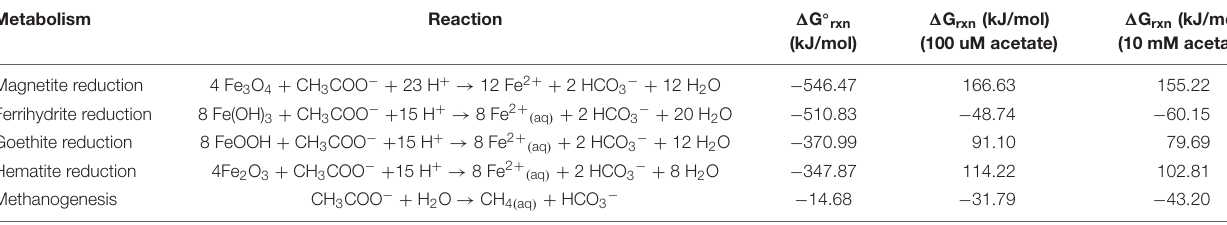
TABLE 1 | (cid:49) G ◦ rxn values for relevant iron-reducing and methanogenesis reactions under standard state conditions. Metabolism